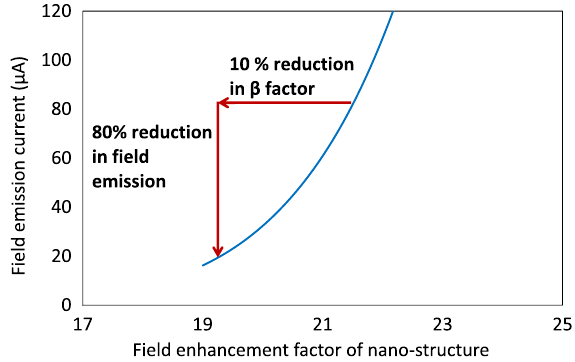
10. Calculation of the field emission using the Fowler- Nordheim equation from a cathode at 300 MV = m with an additional field